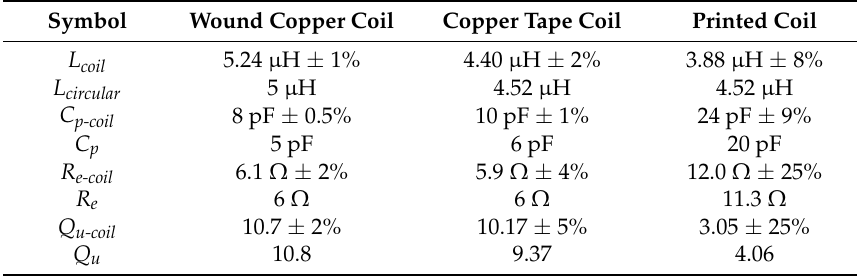
Figure 8. Impedance phase angle of different type of coils on frequency range from 300 kHz to 50 MHz. The self-resonant frequency can be located from this measurement as 10.3 MHz and 17.6 MHz for wound copper coil and flexible coils, respectively. Table 2. Electrical characteristics of